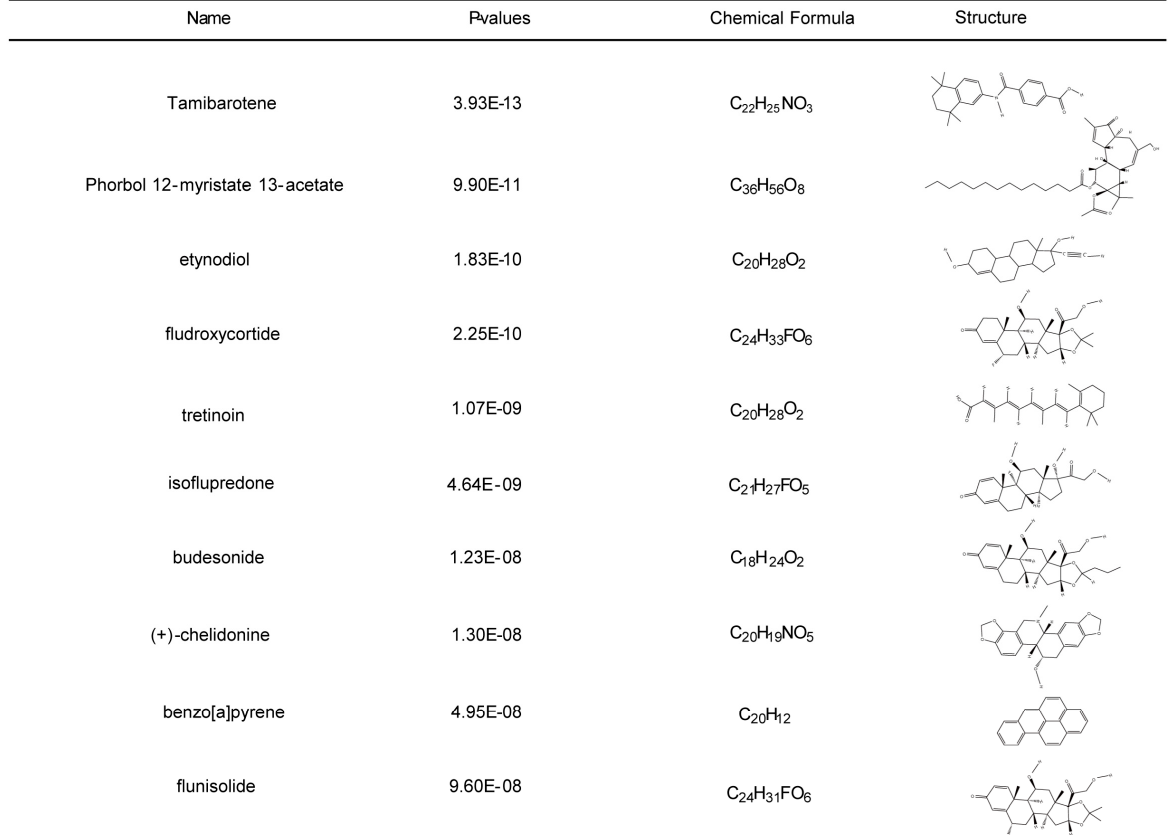
Figure 8. Top ten potential drugs were selected by Enrichr composite score. Ten drug names, p -values, molecular formulas, and two-dimensional structures are shown.